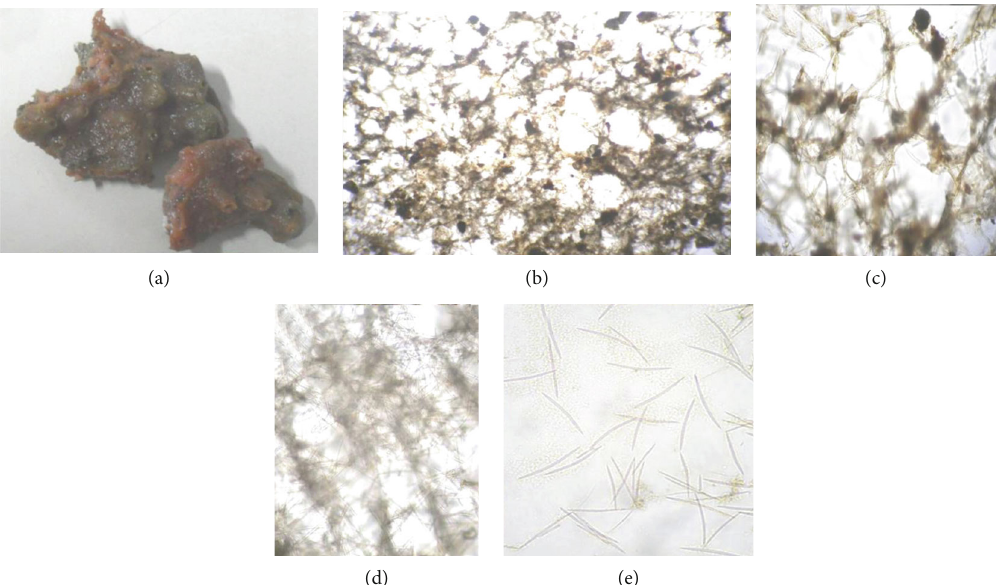
Figure 1: Photographs and micrographs of sponge morphological characters: (a) Haliclona ( Soestella ) sp. showing an irregular growth form; (b, c) cross sections of the ectosomal skeleton displaying multispicular polygonal meshes (400x); (d) cross section of the coanosomal skeleton, with irregular reticulation of primary lines ascending toward the surface, connected by unispicular secondary lines (400x); (e) oxeas of various sizes (1000x). Table 1: E ff ects of Haliclona ( Soestella ) sp. sponge crude extract in the Wistar rat. Treatment